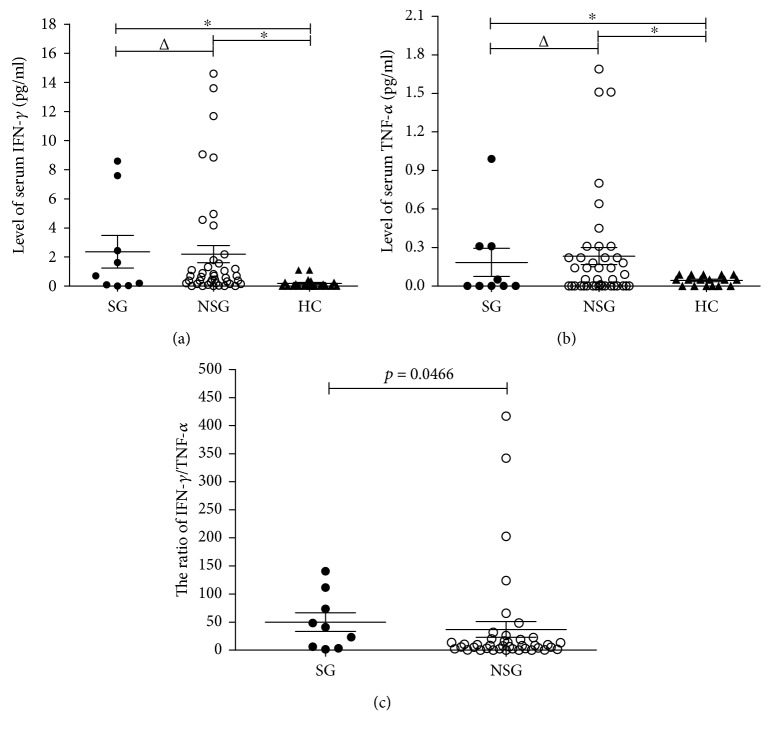
The IFN-γ/TNF-α ratios between brucellosis patients with different severities and healthy subjects. (a) IFN-γ plasma levels were determined by cytometric bead array (CBA) analysis, and Newman-Keuls analysis was used to evaluate the differences among groups. There were no significant differences between the severe and nonsevere groups in IFN-γ (Δp > 0.05), yet significant differences were detected between the patient groups (SG and NSG) and HC in IFN-γ (∗p < 0.05). (b) TNF-α plasma levels were determined by cytometric bead array (CBA) analysis, and Newman-Keuls analysis was used to evaluate the differences among groups. There were no significant differences between the severe and nonsevere groups in TNF-α (Δp > 0.05), yet significant differences were detected between the patient groups (SG and NSG) and HC in TNF-α (∗p < 0.05). (c) IFN-γ/TNF-α ratios for every patient were calculated and plotted for the analysis, which reveals significant differences between the severe and nonsevere groups (p < 0.05). Abbreviations: SG: patients in the severe group; NSG: patients in the nonsevere group; HC: healthy controls. Δp > 0.05; ∗p < 0.05.